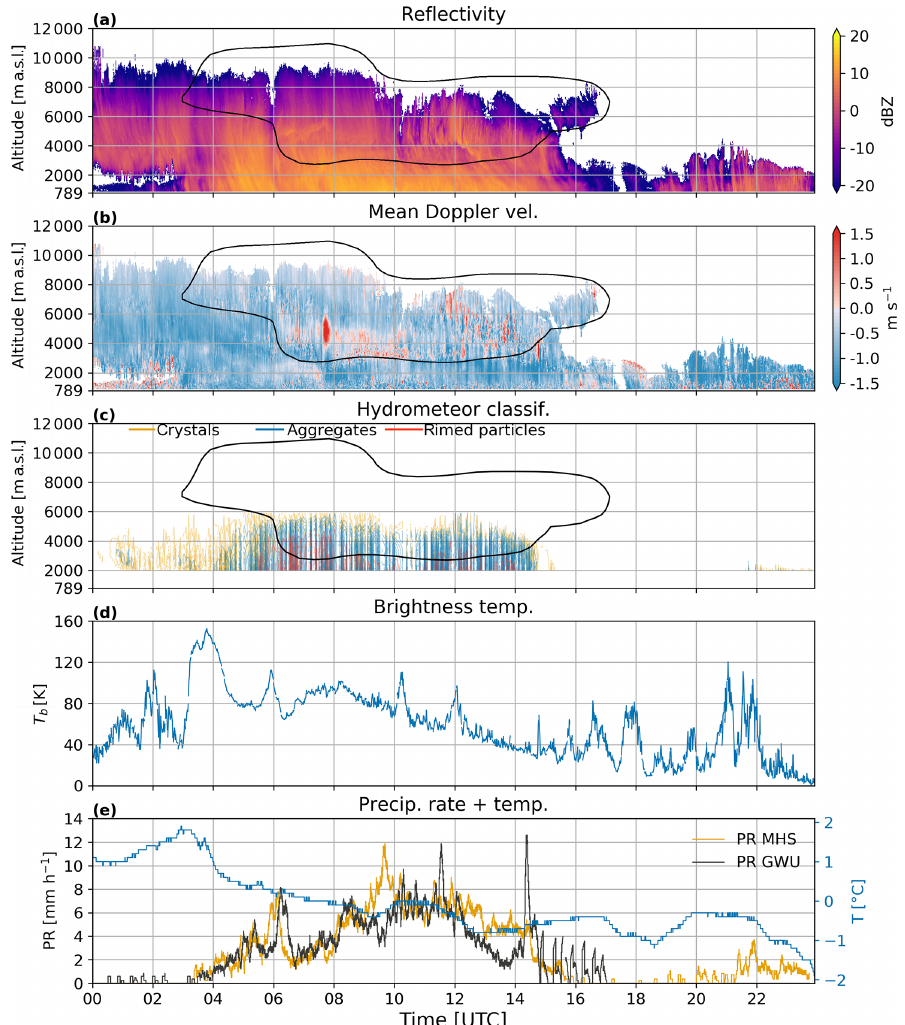
Figure 5. Time series on 28 February 2018 of (a) reflectivity and (b) mean Doppler velocity from WProf (defined positive upwards). (c) Hydrometeor classification (Besic et al., 2018) based on MXPol RHIs towards MHS. Only data with an elevation angle between 5 ◦ and 45 ◦ are considered. The isolines represent the proportion of each hydrometeor class normalised by the average number of pixels per time step. The contour interval is 2%. The yellow contours represent crystals, the blue ones aggregates and the red ones rimed particles. The results are shown only above 2000m since the lower altitudes are contaminated by ground echoes. The black contour in panels (a) , (b) and (c) shows the boundary of the WCB based on the projection of the trajectories in an Eulerian reference frame (see Sect. 2.4). (d) Brightness temperature ( T b ) from the radiometer; (e) precipitation rate (PR; Pluvio 2 weighing rain gauge) at MHS (yellow) and GWU (black) and temperature at MHS